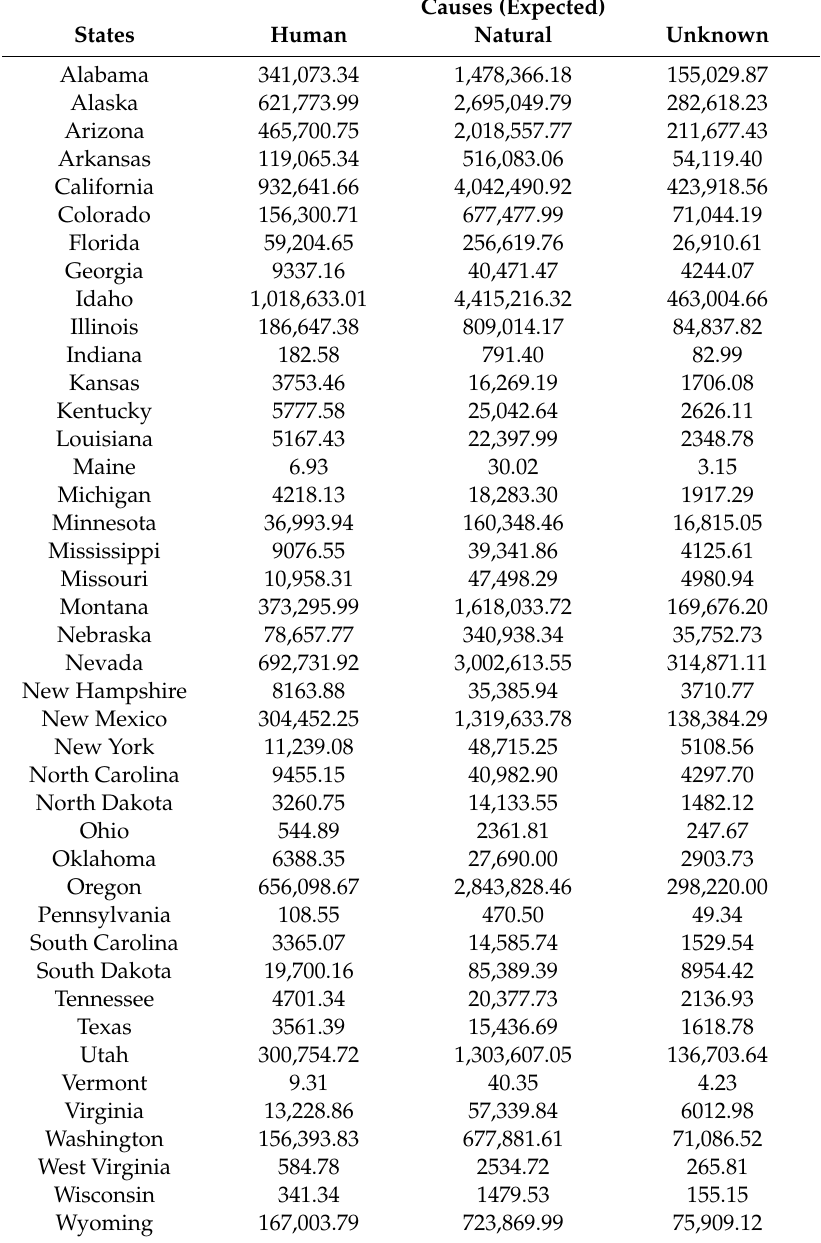
Table 5. Expected frequencies for fire causes and states (number of burned acres). Source: Own elaboration with data from BLM and